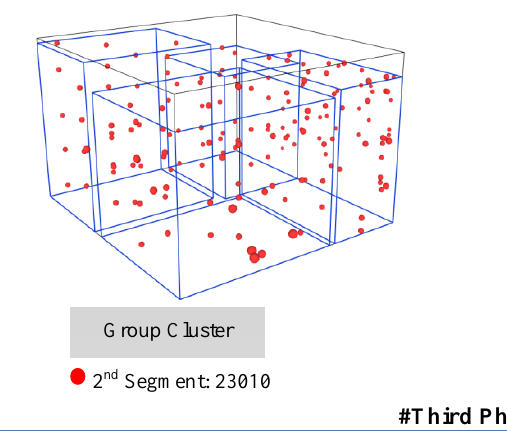
Figure 4. Unique identification of market segments based on geographic criteria.